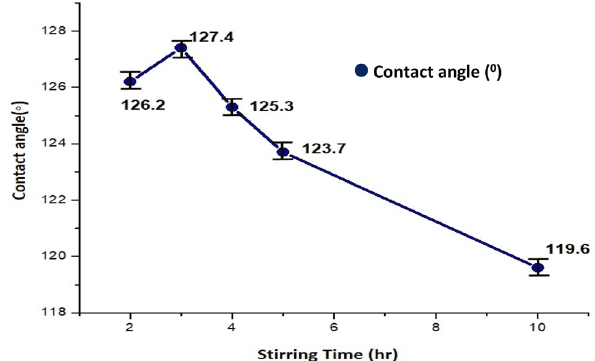
Fig. 10 Different contact angle at different Stirring time